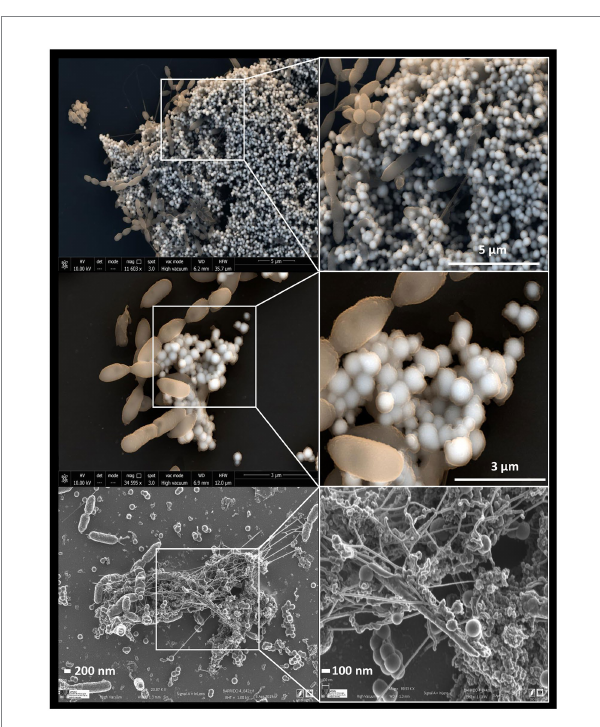
FIGURE 6 Electron microscopy images showing Se 0 nanostructures produced by the bacterium Stenotrophomonas bentonitica when supplemented with Se IV (personal archive of Dr. Merroun; growth conditions detailed in Ruiz Fresneda et al., 2018, 2019,